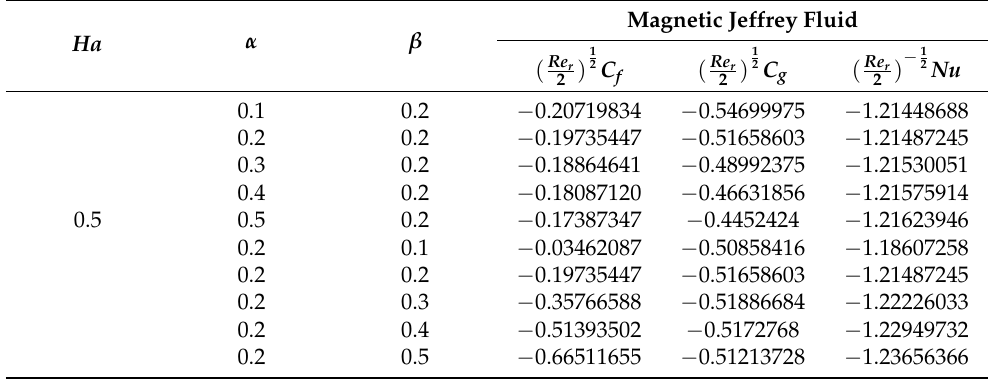
1 1 ) ( Re r ) 2 C 2 C g , and ( Re r f , 2 2